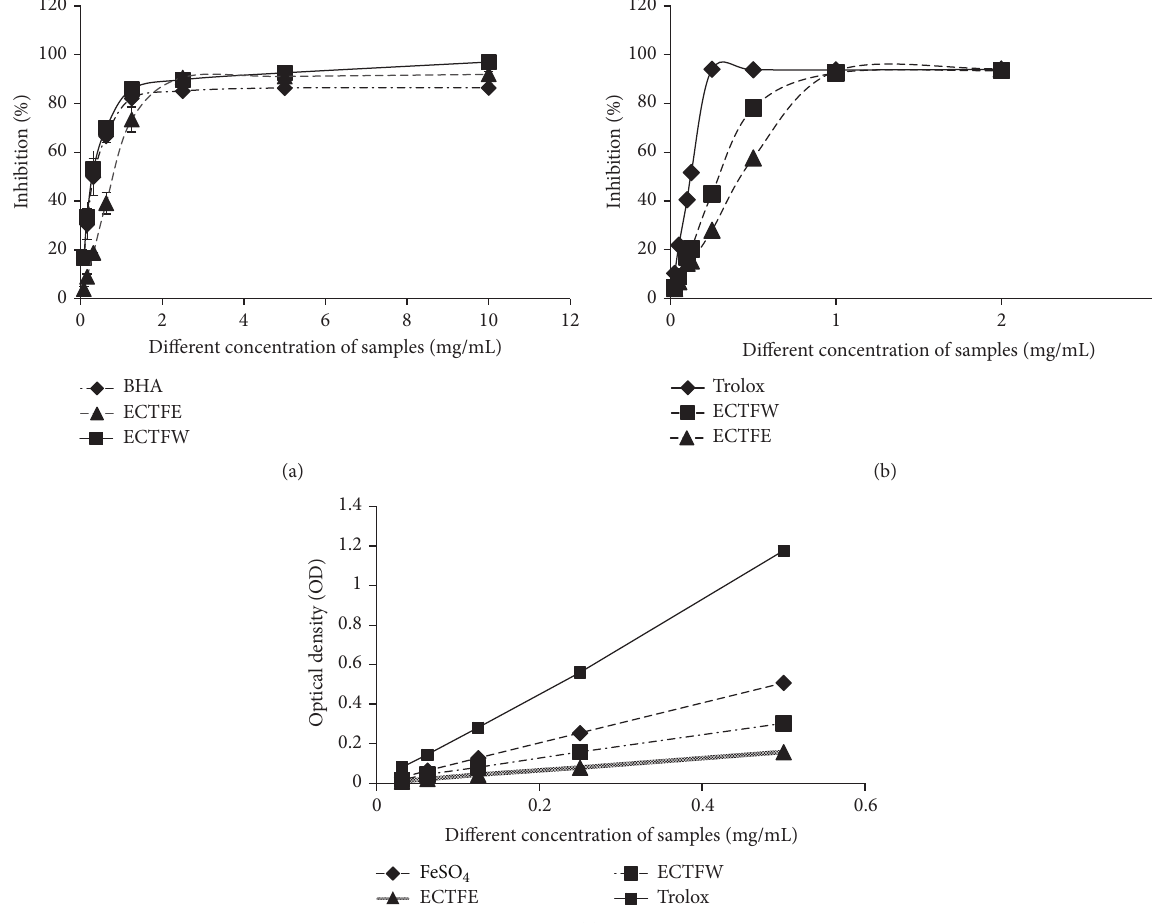
Figure 5: Antioxidant ability of CTF extracts. (a) DPPH free radical-scavenging activity. (b) ABTS radical-scavenging capacity. (c) Ferric- reducing ability power (FRAP) assay. The experiment was performed with